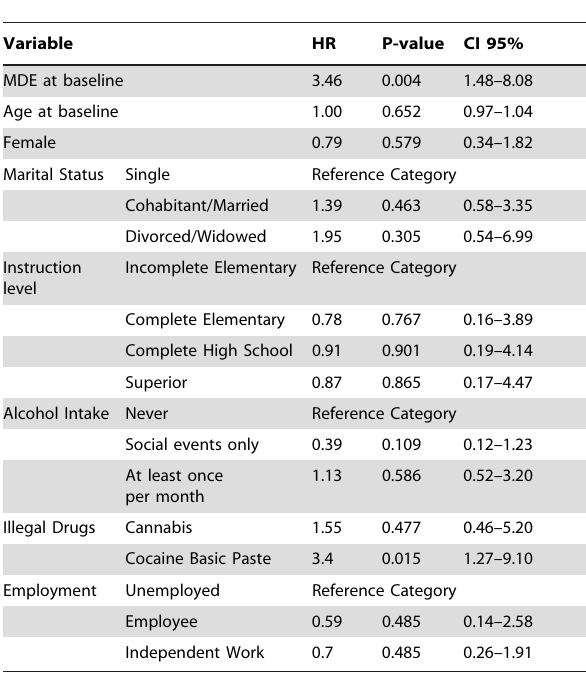
Table 5. Univariate model of MDE as hazard factor for Negative Outcome.